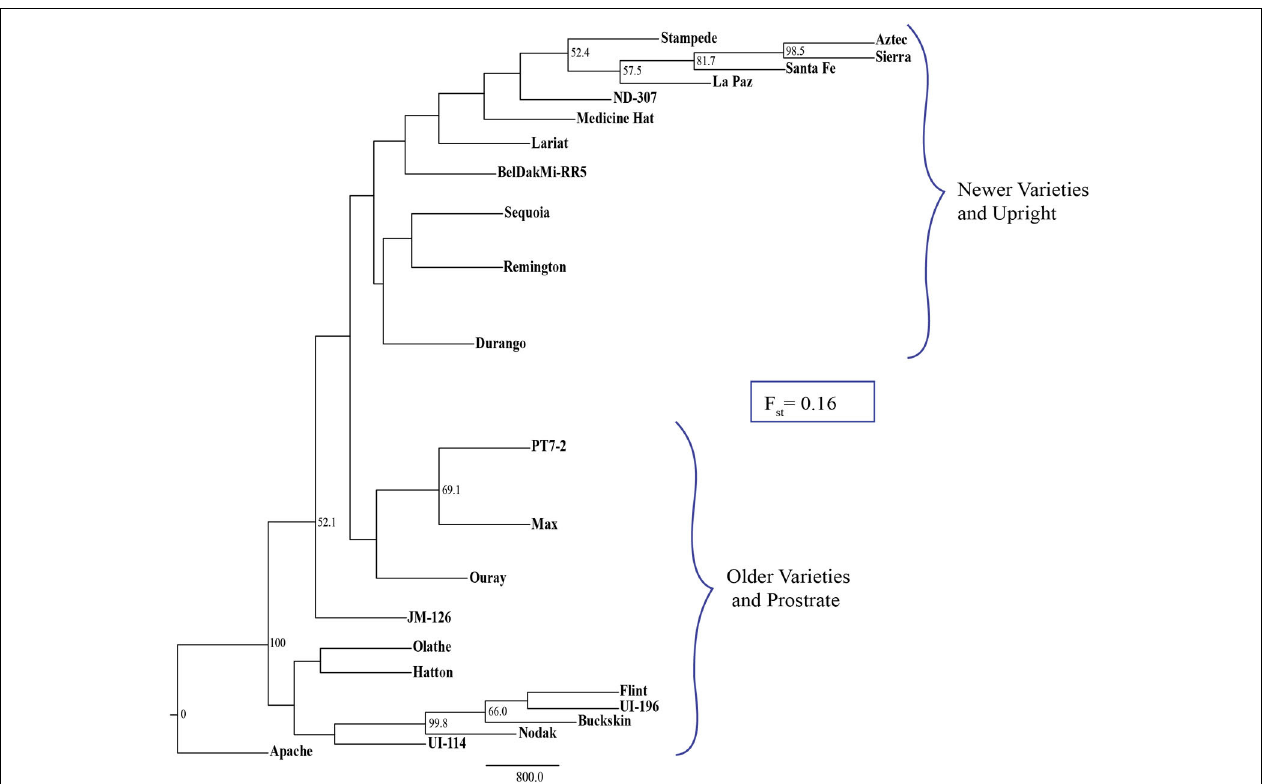
FIGURE 4 | Neighbor joining tree of 24 pinto genotypes that cluster into two distinct groups (i) newer varieties with type II growth habit and (ii) older varieties with type III growth habit.